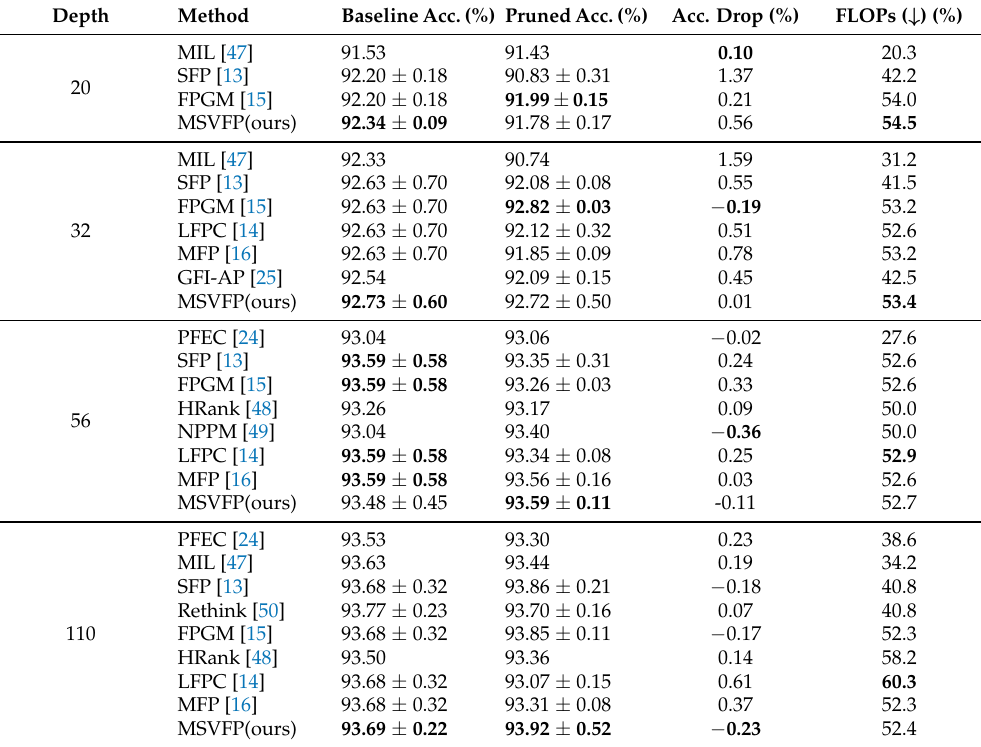
Table 4. Comparison of pruned ResNet models on the CIFAR-10 dataset. FLOPs ( ↓ ) (%) represents, the FLOPs reduction rate between the baseline model and pruned model. “Acc. drop” is the top-1 accuracy difference between the baseline model and pruned